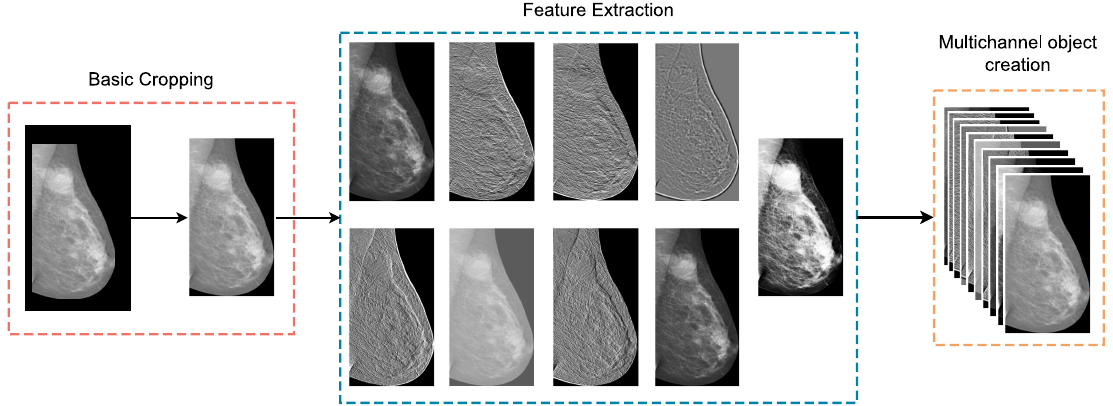
is applied on the input image and low-level features are extracted using digital filters.